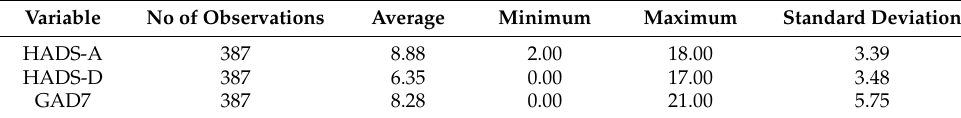
Table 2. General characteristics of the group in relation to the scales analysed.